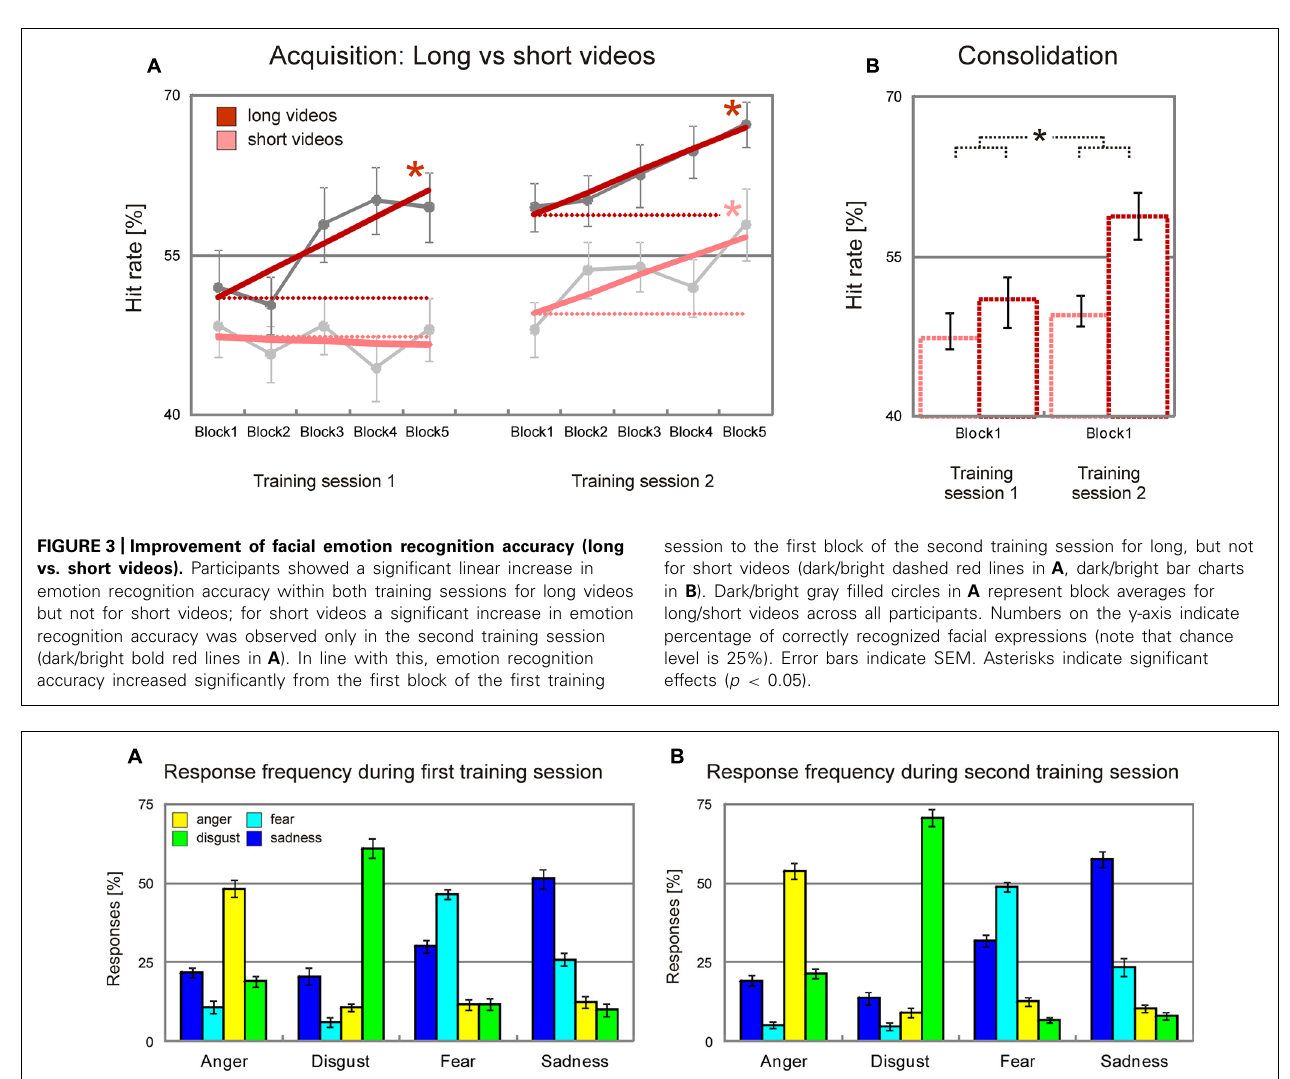
FIGURE 4 | Response frequency during the first (A) and the second training session (B). Error bars indicate